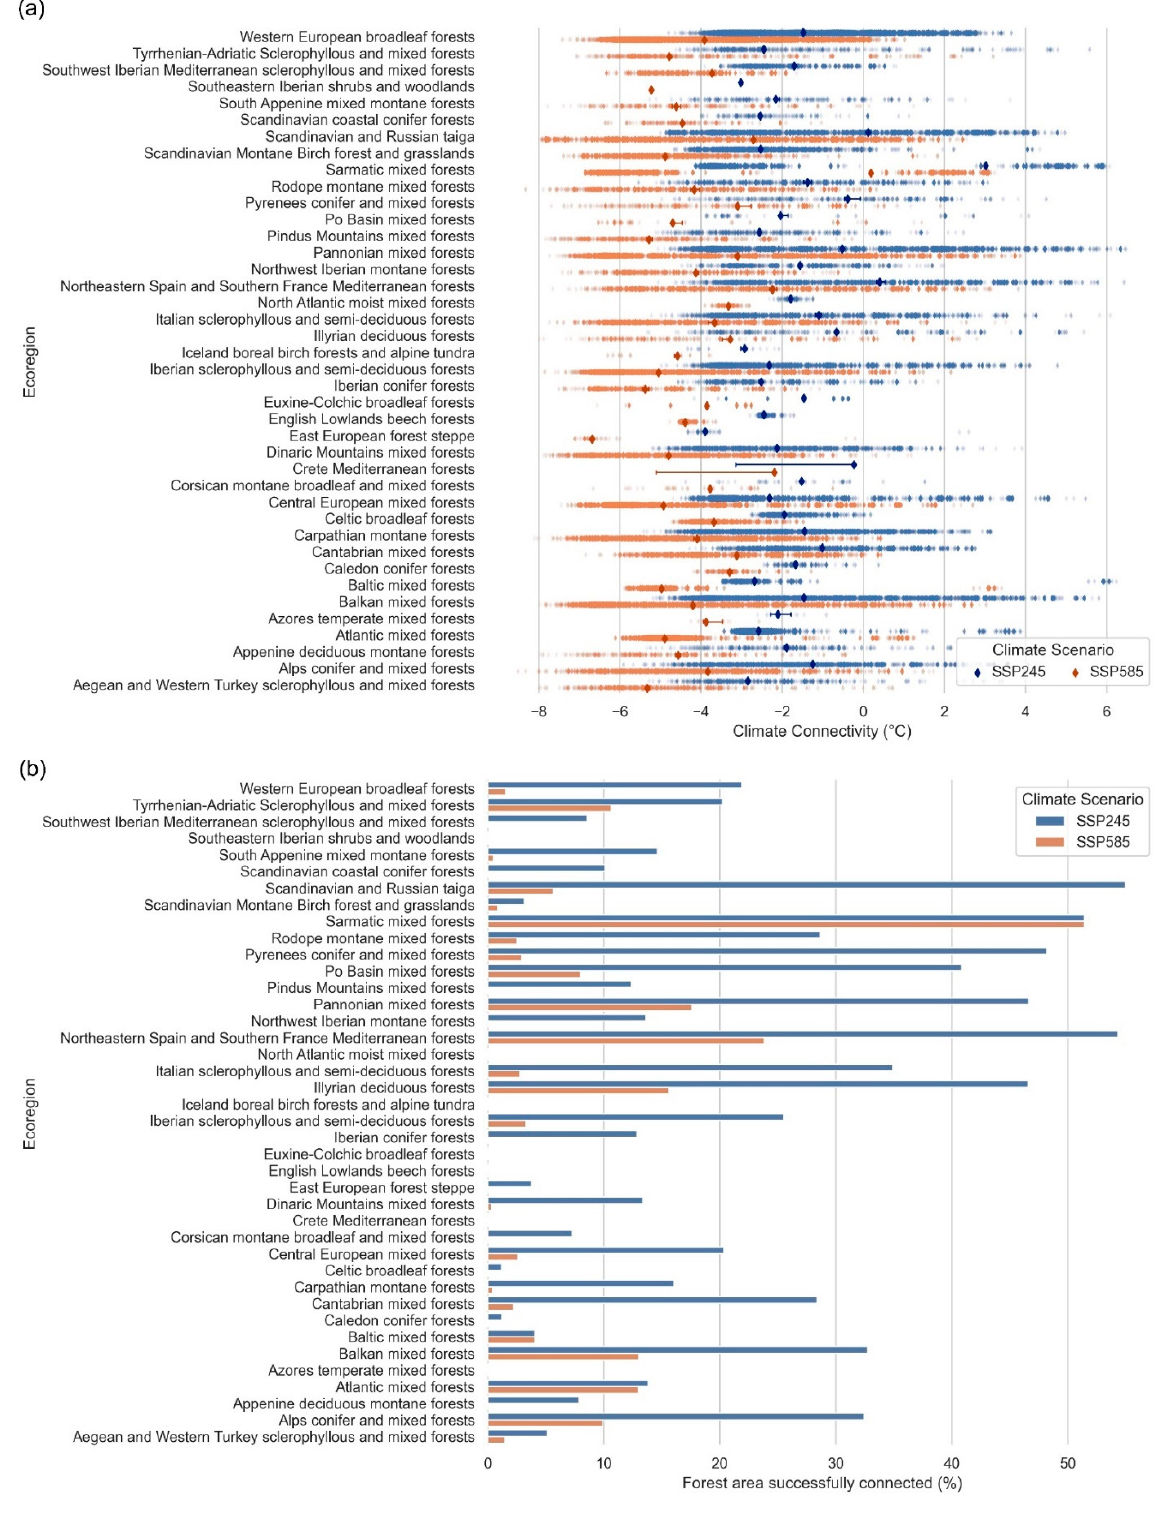
Figure 3. Climate connectivity of forested areas across Europe, summarised by forest ‐ dominated ecoregions. ( a ) Climate connectivity values. Climate connectivity under SSP245 is represented by blue points and under SSP585 by orange points. Solid points are median values with 95% confidence intervals and semi ‐ transparent points in the background are raw data for the climate connectivity of all forested cells (1 km 2 ). ( b ) Proportion of the total forested area that has achieved sufficient climate connectivity in each ecoregion. Only forested cells with zero or positive climate connectivity values were taken into account.